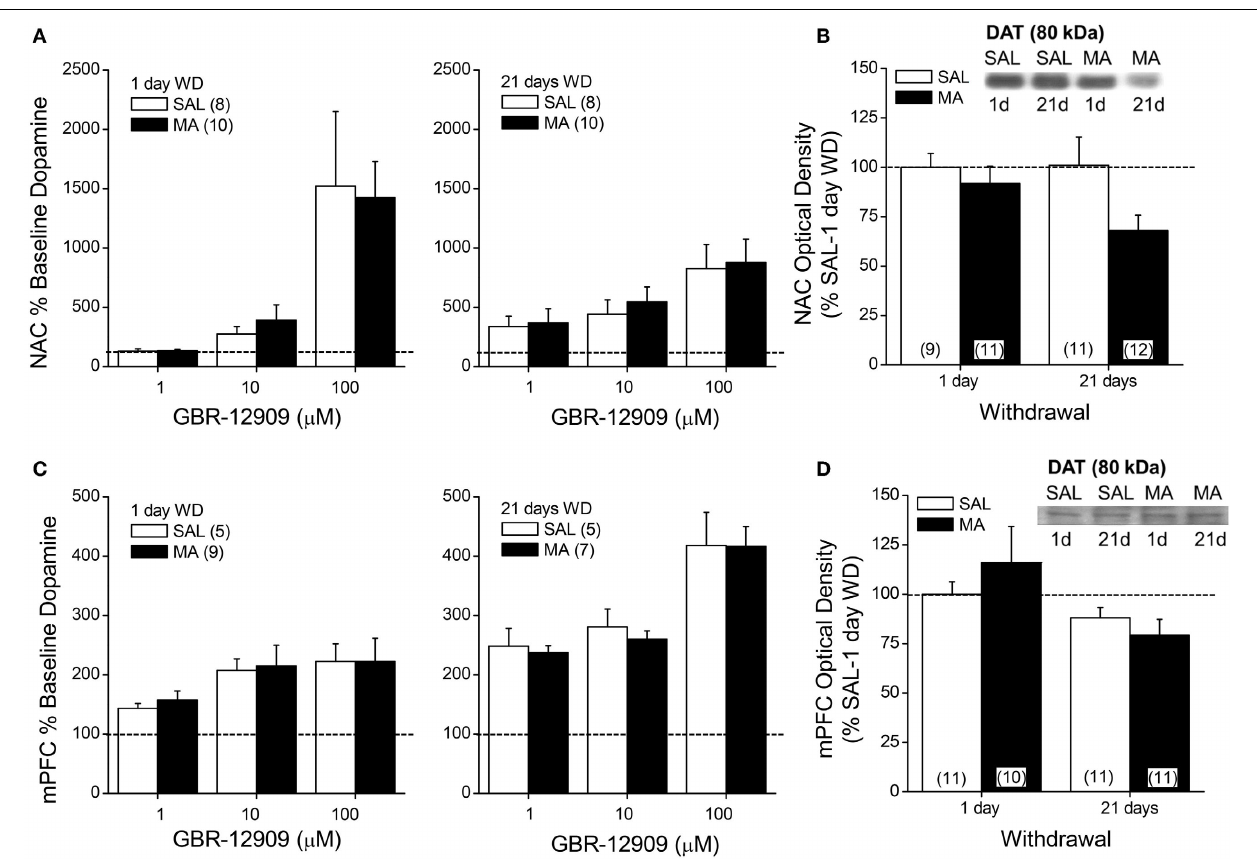
FIGURE 3 | Summary of the effects of a 10-day history of repeated methamphetamine (MA; 2mg/kg) or saline (SAL) upon the capacity of the DAT reuptake inhibitor GBR-12909 to elevate extracellular dopamine (A,C) and upon total DAT protein expression (B,D) within the NAC (top